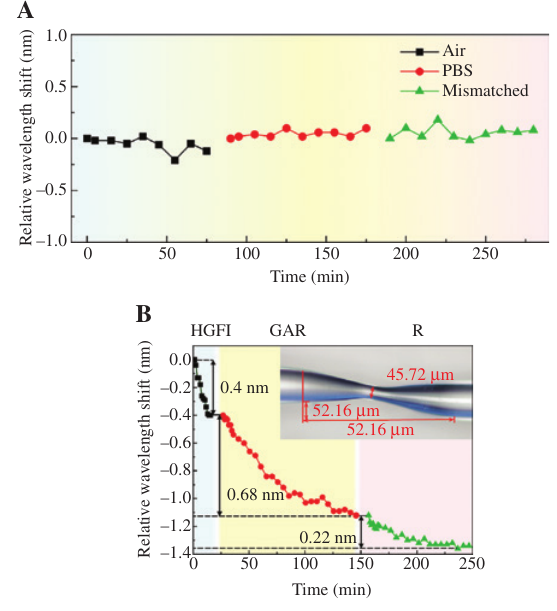
Figure 8: Sensor specificity and repeatability. (A) Temporal evolution of relative wavelength shift for the fabricated fibre taper sensor in air, PBS solution, and GAM antigen solution environments, respectively. (B) Real-time relative wavelength shift of the additional sensor for comparison